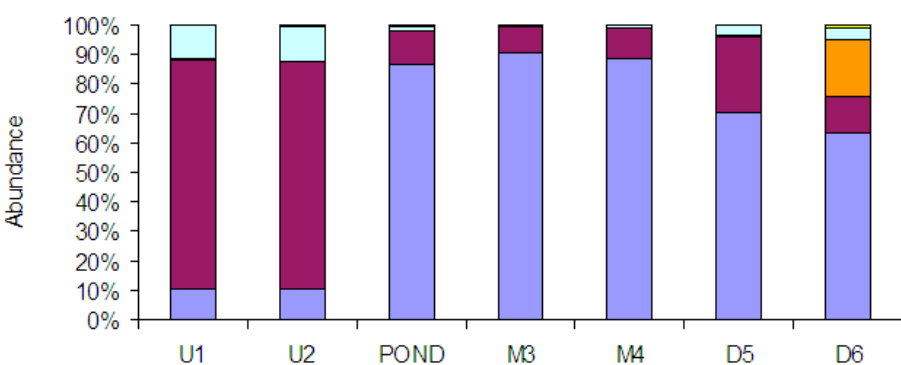
Figure 5. Spatial changes of percentage abundance of zooplankton groups at two sites in the upper section (U1, U2), in POND, at two sites in the middle section (M3, M4), and at two sites in the downstream section (D5, D6) of the Bukówka stream.